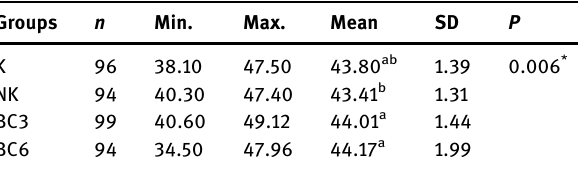
Table 3: Comparison of groups in terms of chick weight ( P < 0.05 ) Groups